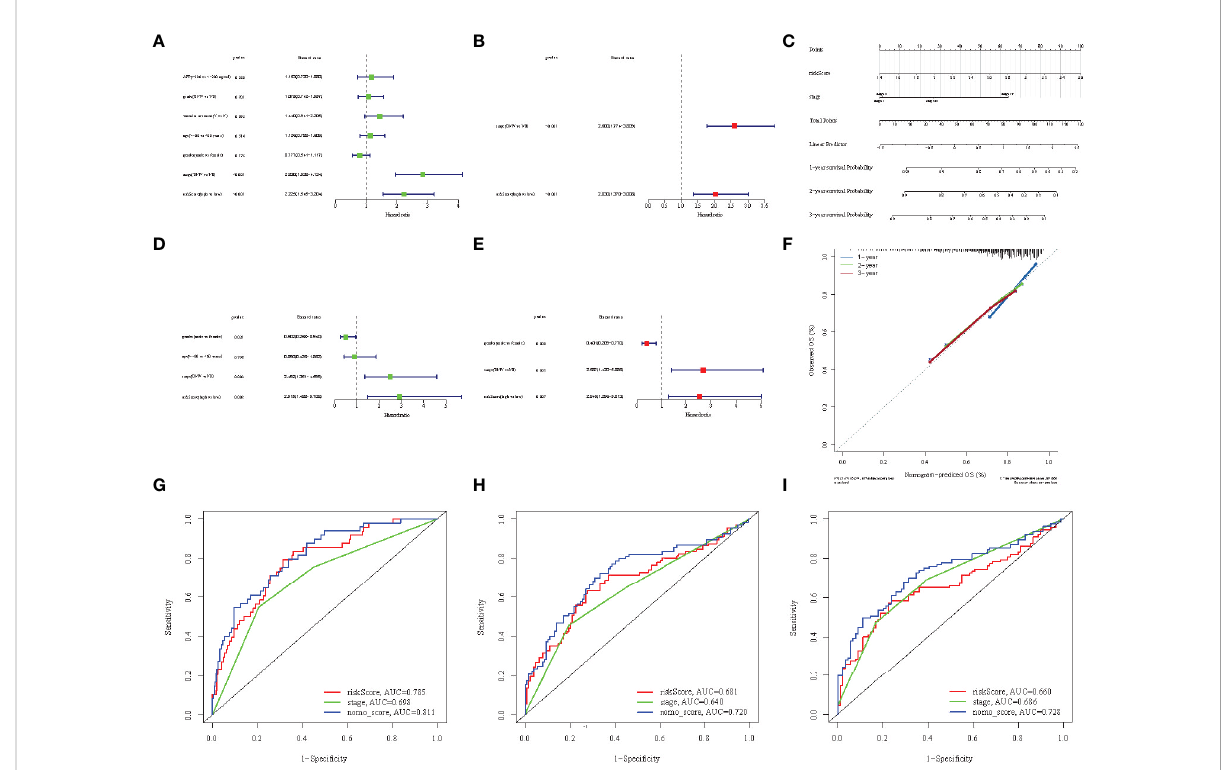
FIGURE 6 Univariate Cox regression analyses of overall survival in the TCGA (A) and ICGC (D) cohorts, and multivariate Cox regression analyses of overall survival in the TCGA (B) and ICGC (E) cohorts. (C) Nomograms for predicting 3-year survival in the TCGA cohort. (F) Calibration curves for the nomograms the TCGA cohort. (G-I) ROC curves for 1, 2, and 3-year time showing the comparison between the survival prediction ability of each nomogram and other risk